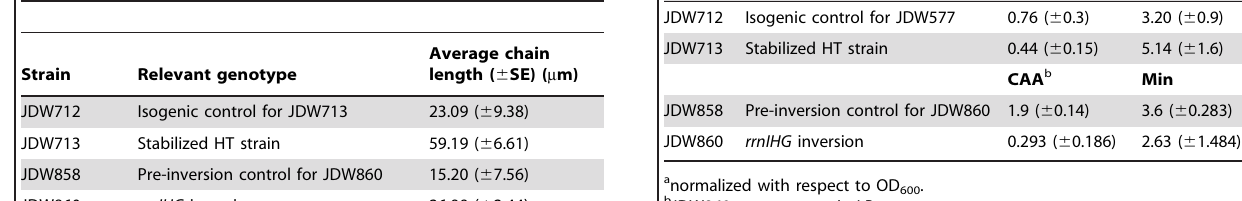
Table 2. Increased length of chains of cells in rich medium.